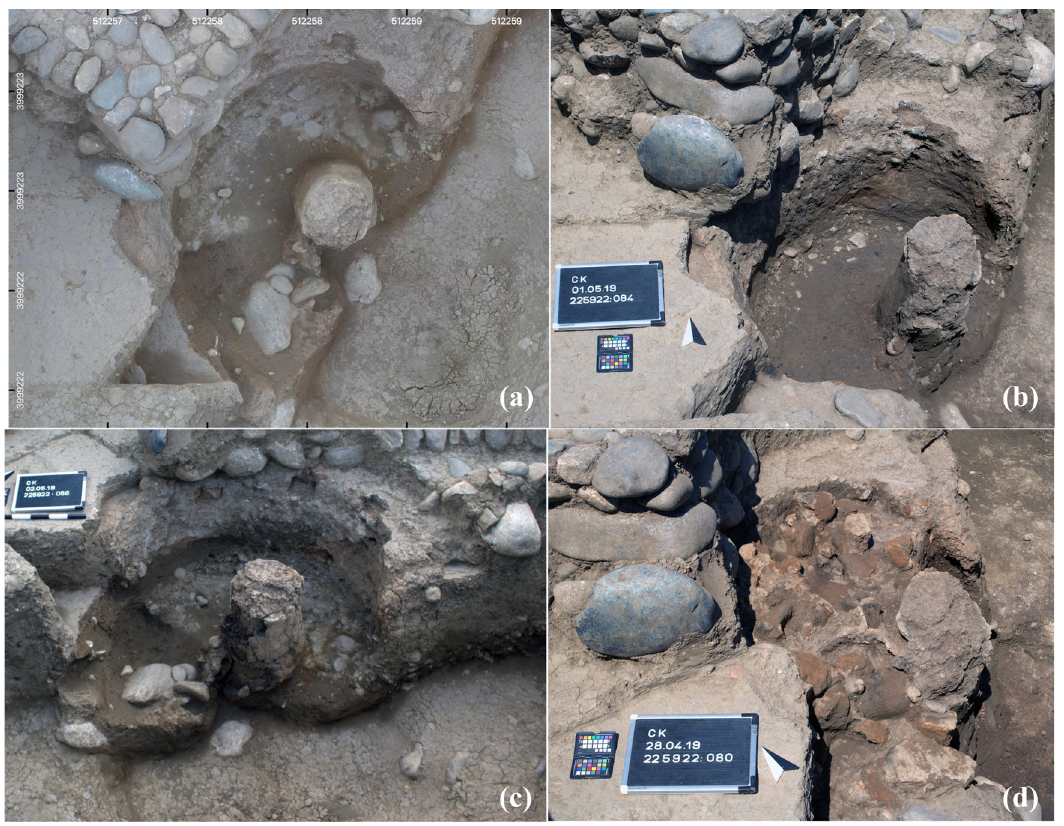
Figure 3: The Chalcolithic kiln at di ff erent stages of the excavation. ( a ) Orthophoto showing the last phase of excavation; ( b ) fi eld photo showing the last phase of excavation; ( c ) fi eld photo showing the partially excavated kiln ’ s fi ll; and ( d ) fi eld photo showing the collapse of the upper structure in the kiln ’ s fi ll. Photos by Jens Rohde, Sophie Pietsch, and Andrea